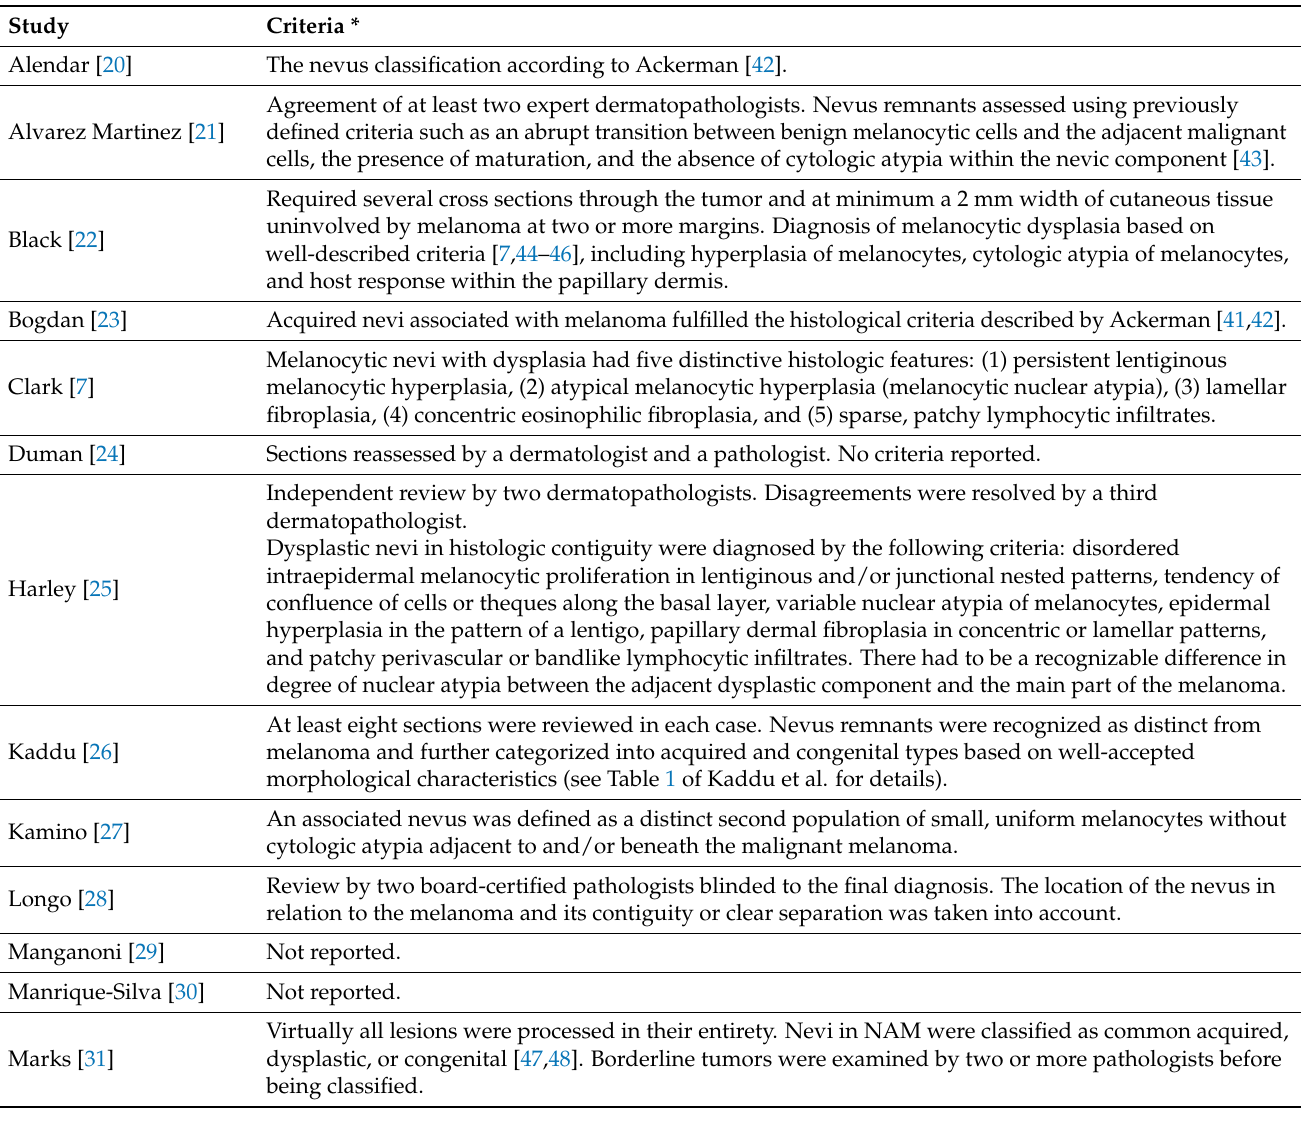
Table 2. Histopathological criteria for dysplastic nevus remnants in nevus-associated melanoma as defined in included individual